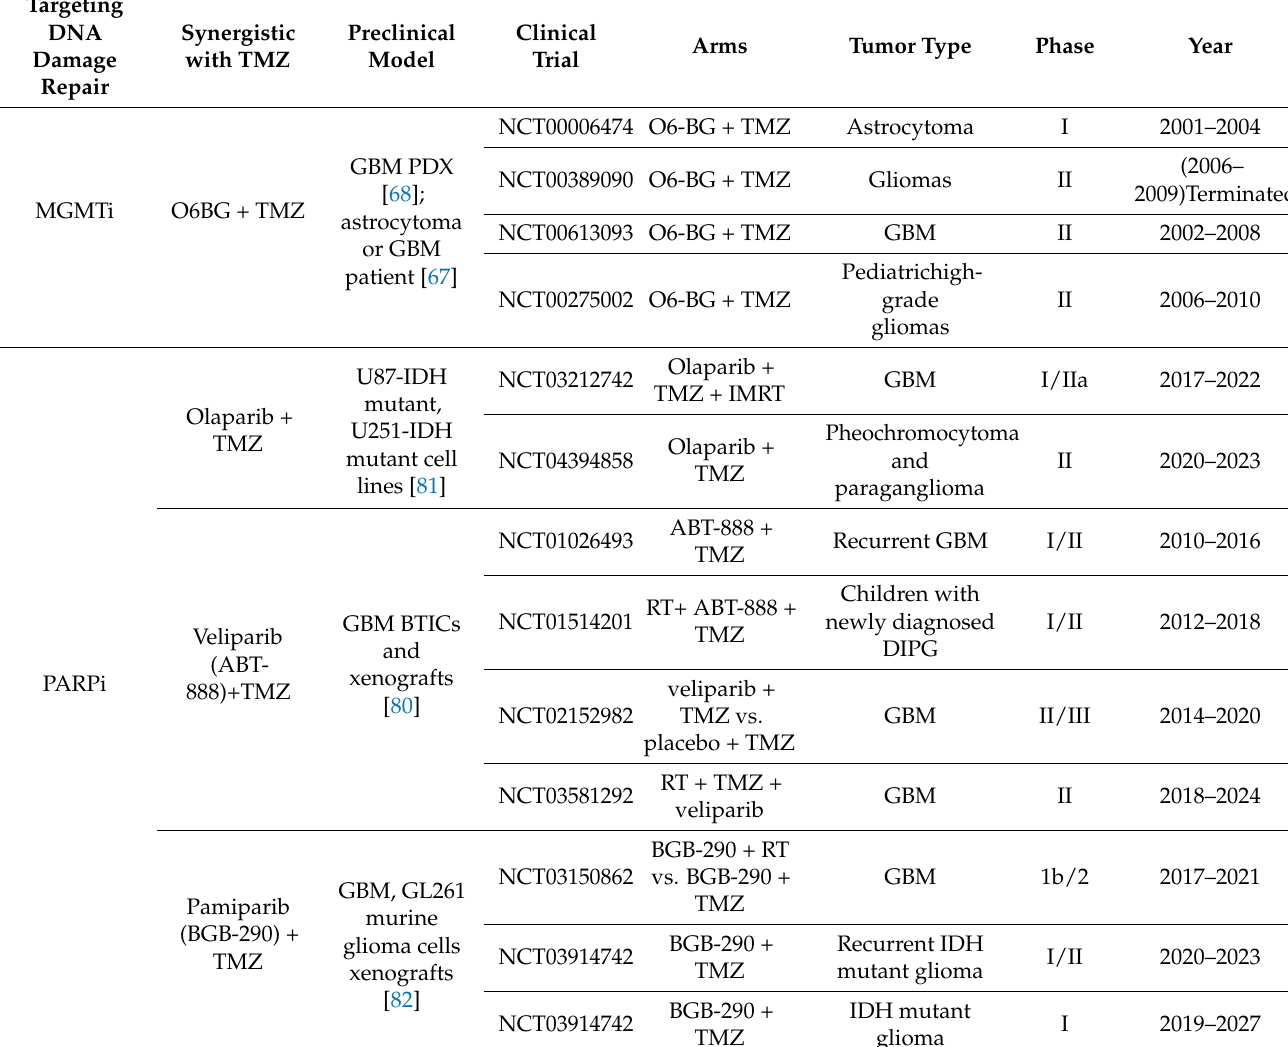
Table 2. Preclinical and clinical studies of combination therapy of TMZ with DNA damage repair pathway inhibitors. Targeting